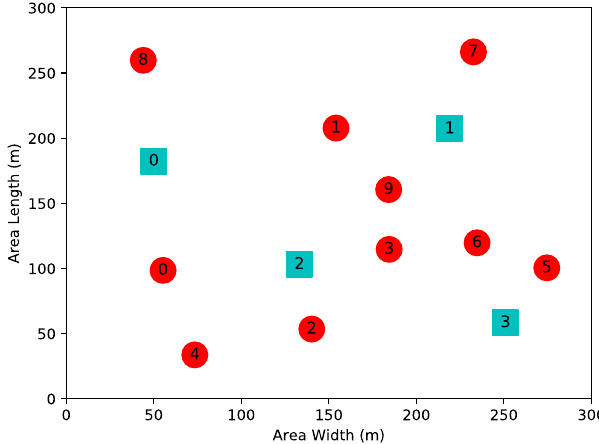
Figure 2. Network topology consisting of 10 SUs and 4 PUs.